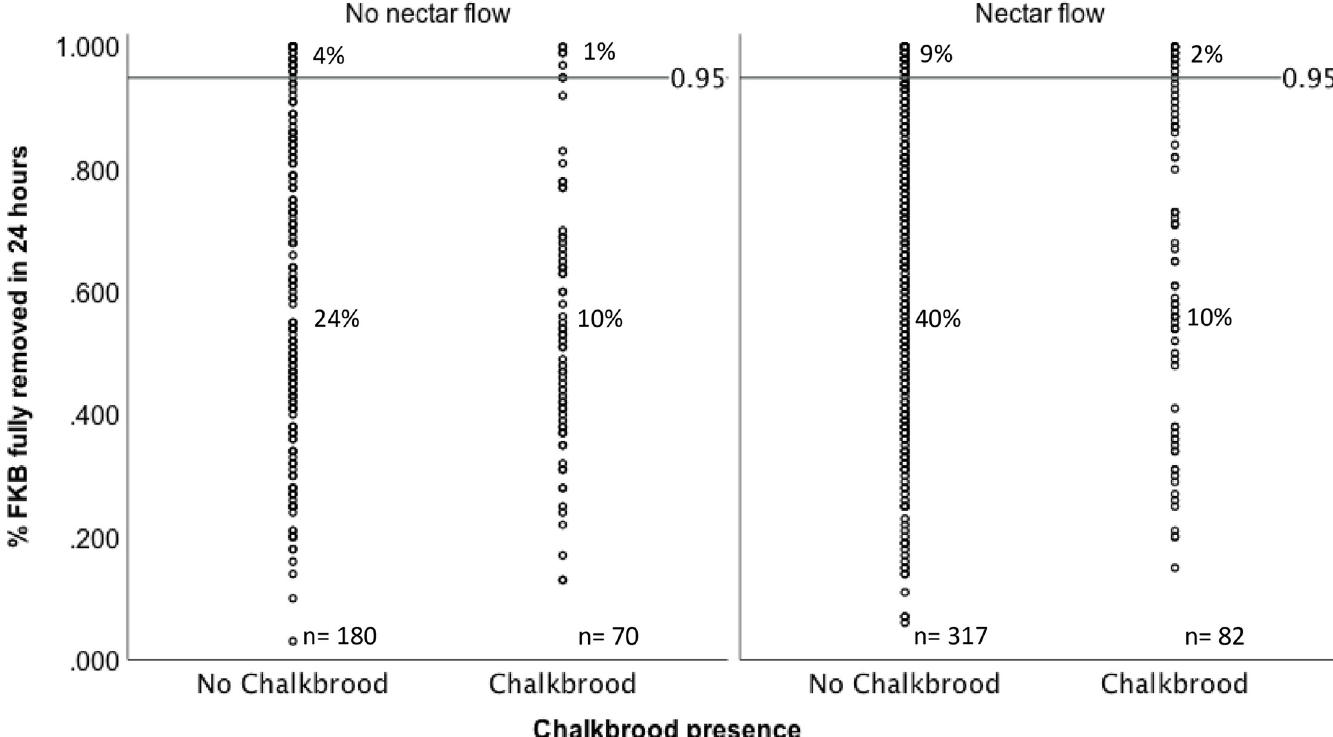
Fig 3. Chalkbrood presence in honey bee colonies is not influenced by level of strict hygienic behaviour (FKB test) or nectar flow. Strict hygienic behaviour scores of colonies with and without chalkbrood under variable nectar conditions. Percentages are out of 649 colonies.